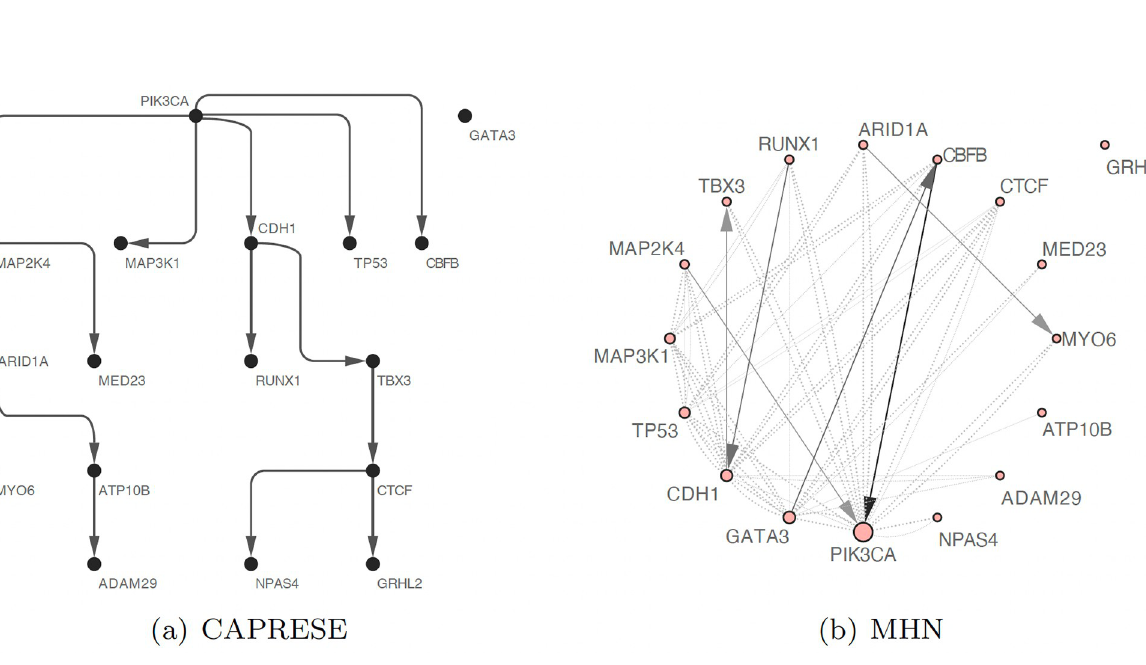
PLOS ONE | https://doi.org/10.1371/journal.pone.0283004 March 16, 2023 11 /